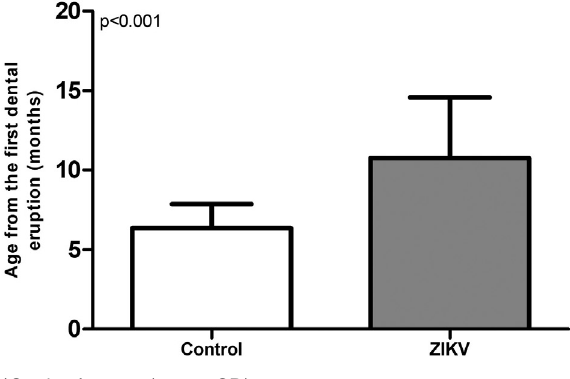
children*Student’s t-test (mean±SD) Figure 4- Age at which the first tooth erupted in ZIKV and control